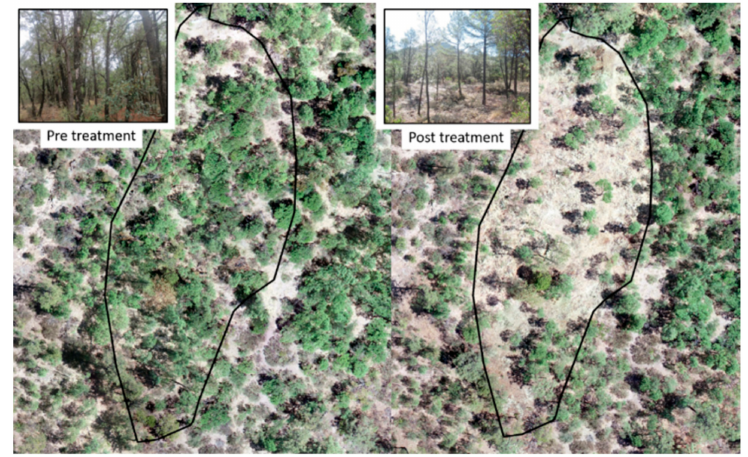
Figure 2. Aerial image from a drone showing the characteristics of micro-catchment 2 before thinning ( left ) and after 80% thinning ( right ).